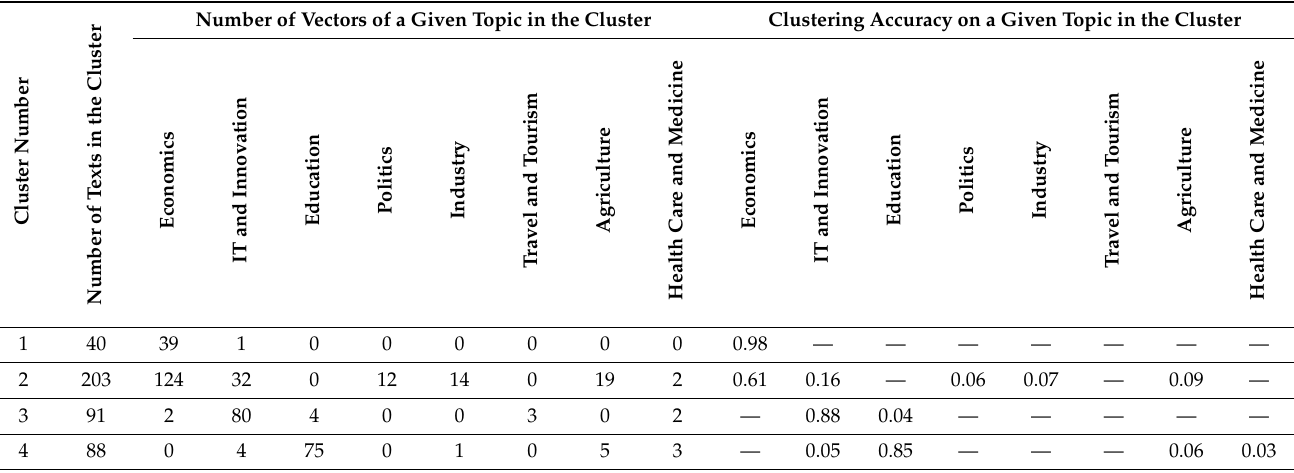
Table 2. Results of clustering the studied text corpus and assessment of its completeness based on document semantic characteristics for vector